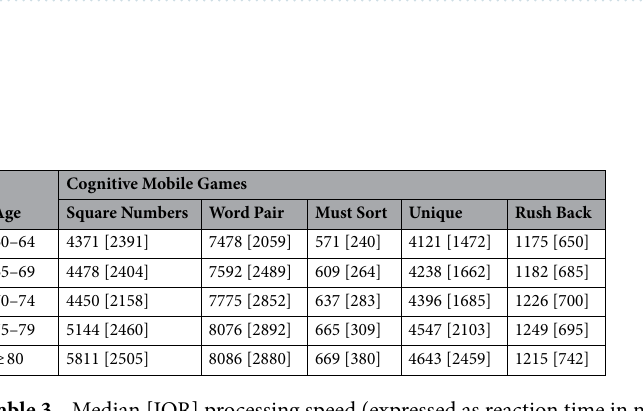
Table 3. Median [IQR] processing speed (expressed as reaction time in ms) for the different CMG according to the age of the participants for the first session of